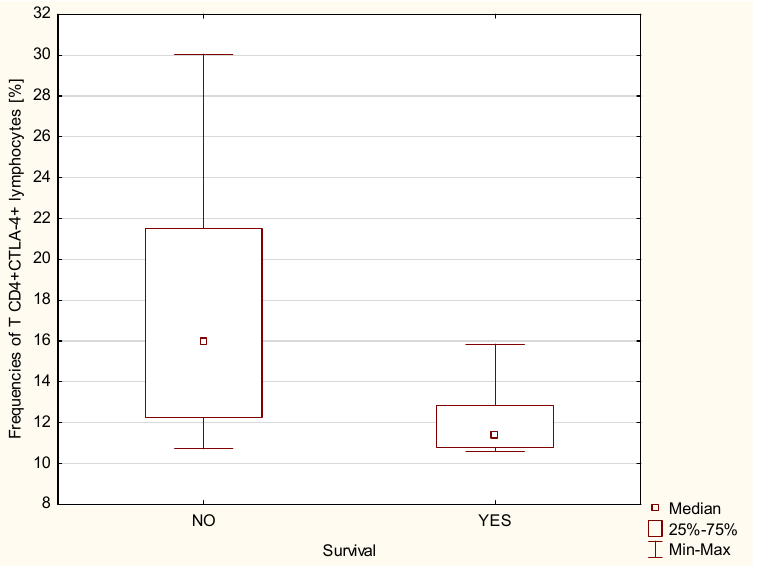
Figure 5. Percentage of CD4+CTLA4+ T lymphocytes in iPAH patients taking into account the survival of patients with iPAH ( p ≤ 0.01).